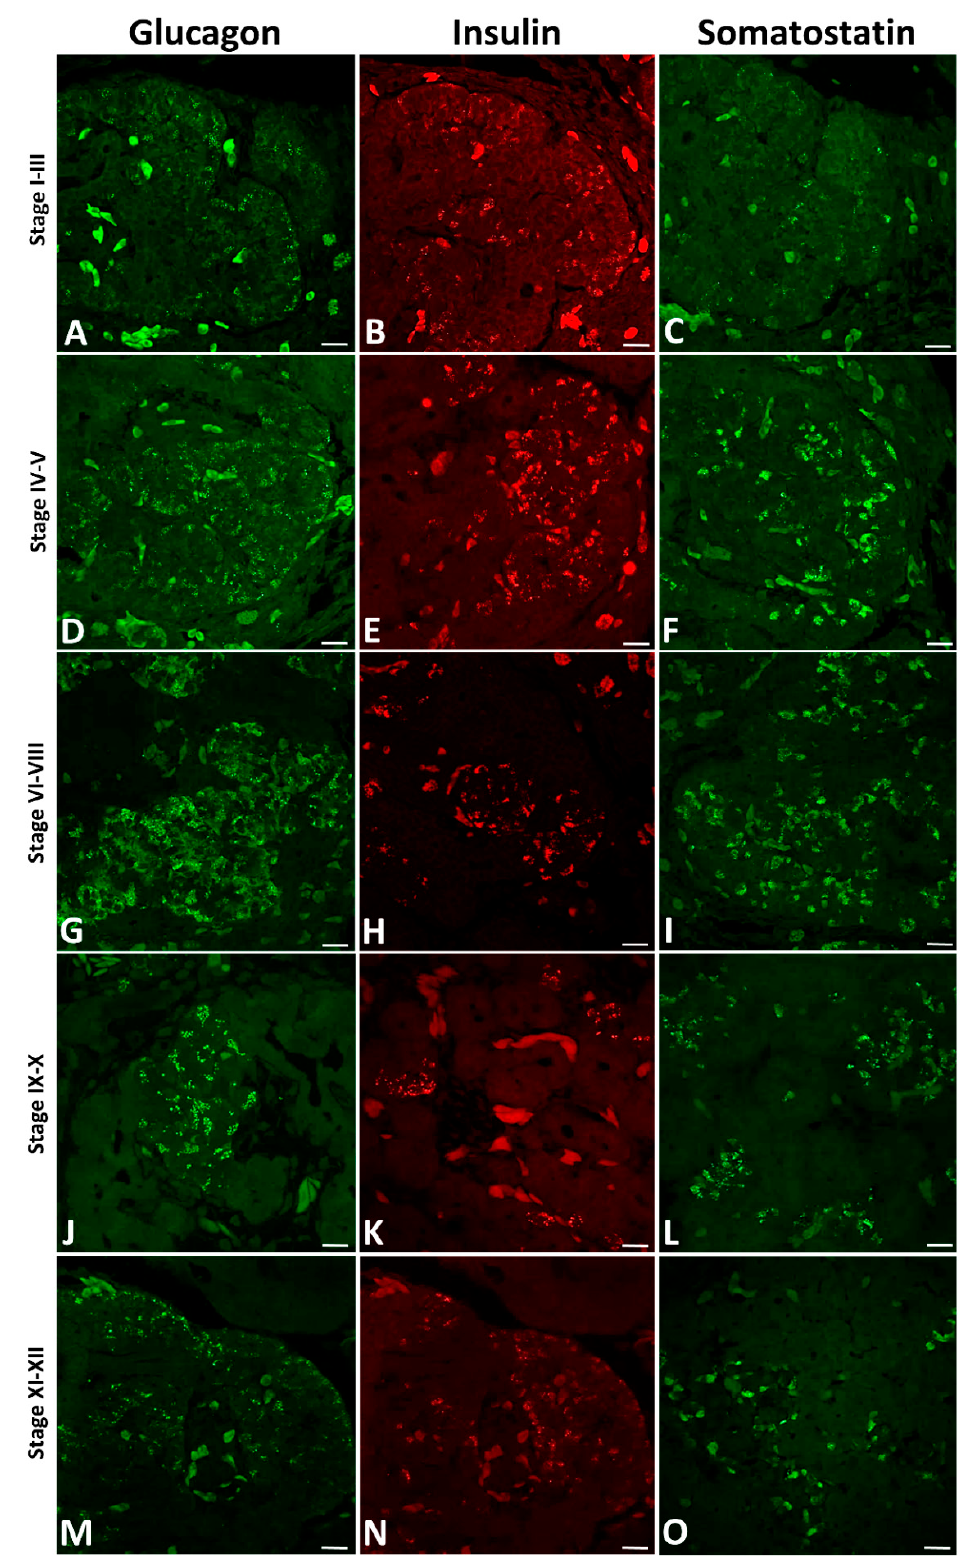
Figure 8. Arrangement of three main pancreatic hormones (glucagon, insulin, and somatostatin) within the pancreas of the grass snake embryos at subsequent developmental stages. ( A , D , G , J , M ) Fluorescence for glucagon. ( B , E , H,K,N ) Fluorescence for insulin. ( C , F , I , L , O ) Fluorescence for somatostatin. Scale bars—50 µ